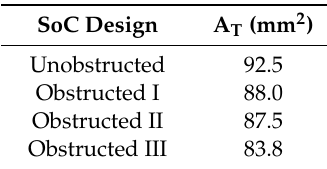
Table 1. Total area of the four tested SoC